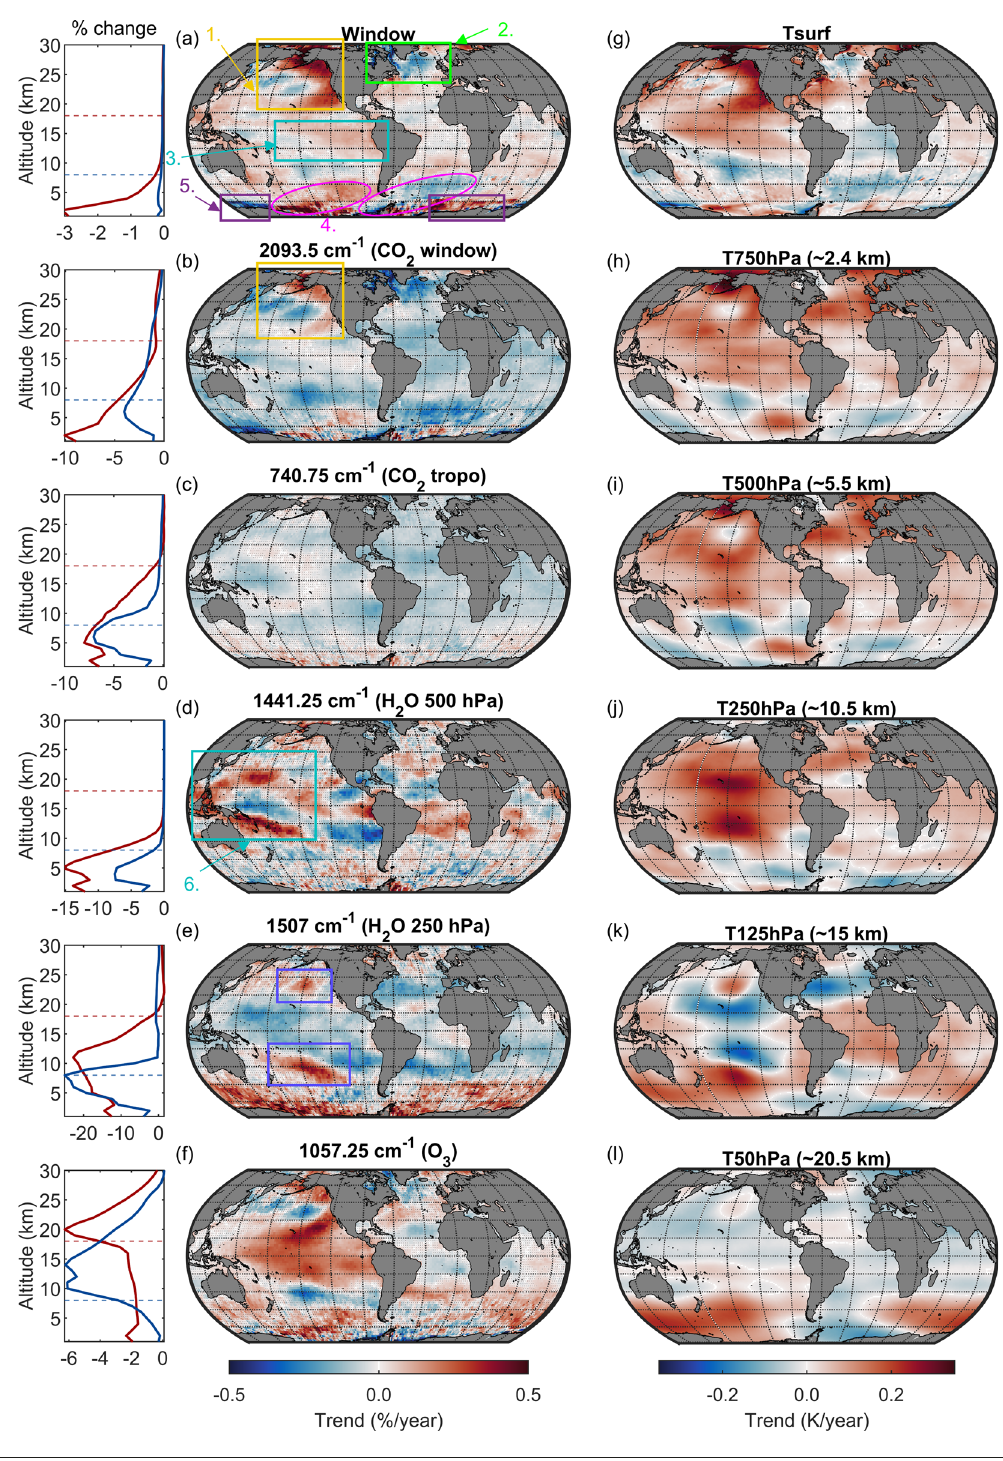
Fig. 2 Global LT in the SOLR for a set of selected channels and in atmospheric temperature at different altitudes. a – f Left panels: layer effect on the IASI channel radiance for a tropical (red) and a subarctic (blue) standard atmosphere. The dashed lines show the altitude of the tropopause. Right panels: SOLR linear trends distributions on a 2° × 2° grid from 10 years (2008 – 2017) of IASI-derived clear-sky SOLR (percentage per year) for a the integrated [795 – 970 cm − 1 ; 1070 – 1230 cm − 1 ] window region, b a CO 2 window channel, c a CO 2 tropospheric channel, d a H 2 O mid-tropospheric sensitive channel, e a H 2 O upper-tropospheric sensitive channel, and f an O 3 stratospheric sensitive channel. Stippling indicates trends non-statistically signi fi cantly different from zero at the 95% con fi dence level. The colored areas indicate the identi fi ed climate phenomena. The colorscale range from − 0.5 to 0.5, except for the two H 2 O and the CO 2 window channel distributions where it ranges from − 1 to 1. g – l Linear trends distributions of the surface and atmospheric temperatures at different levels of pressure based on 10 years (2008 – 2017) of ERA5 reanalysis dataset on a 1° × 1° grid 31 . Corresponding altitudes are indicated as